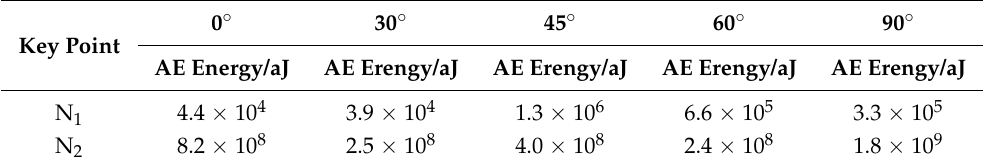
Table 3. AE energy levels for different bedding angles under natural state.